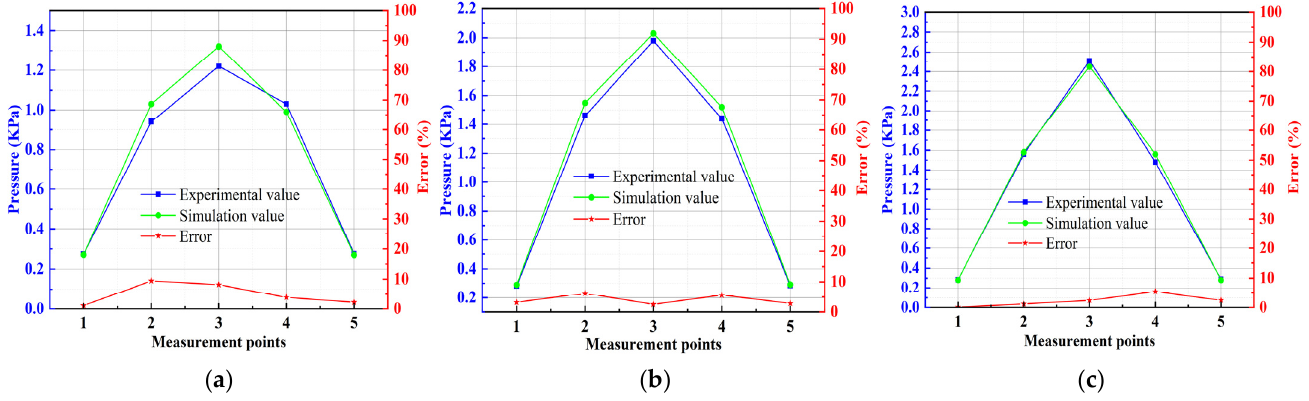
Figure 16. Comparison between simulation and test of outlet air pressure at different negative pressures: ( a ) comparison of outlet air pressure at 2400 Pa; ( b ) comparison of outlet air pressure at 2800 Pa; ( c ) comparison of outlet air pressure at 3200 Pa.